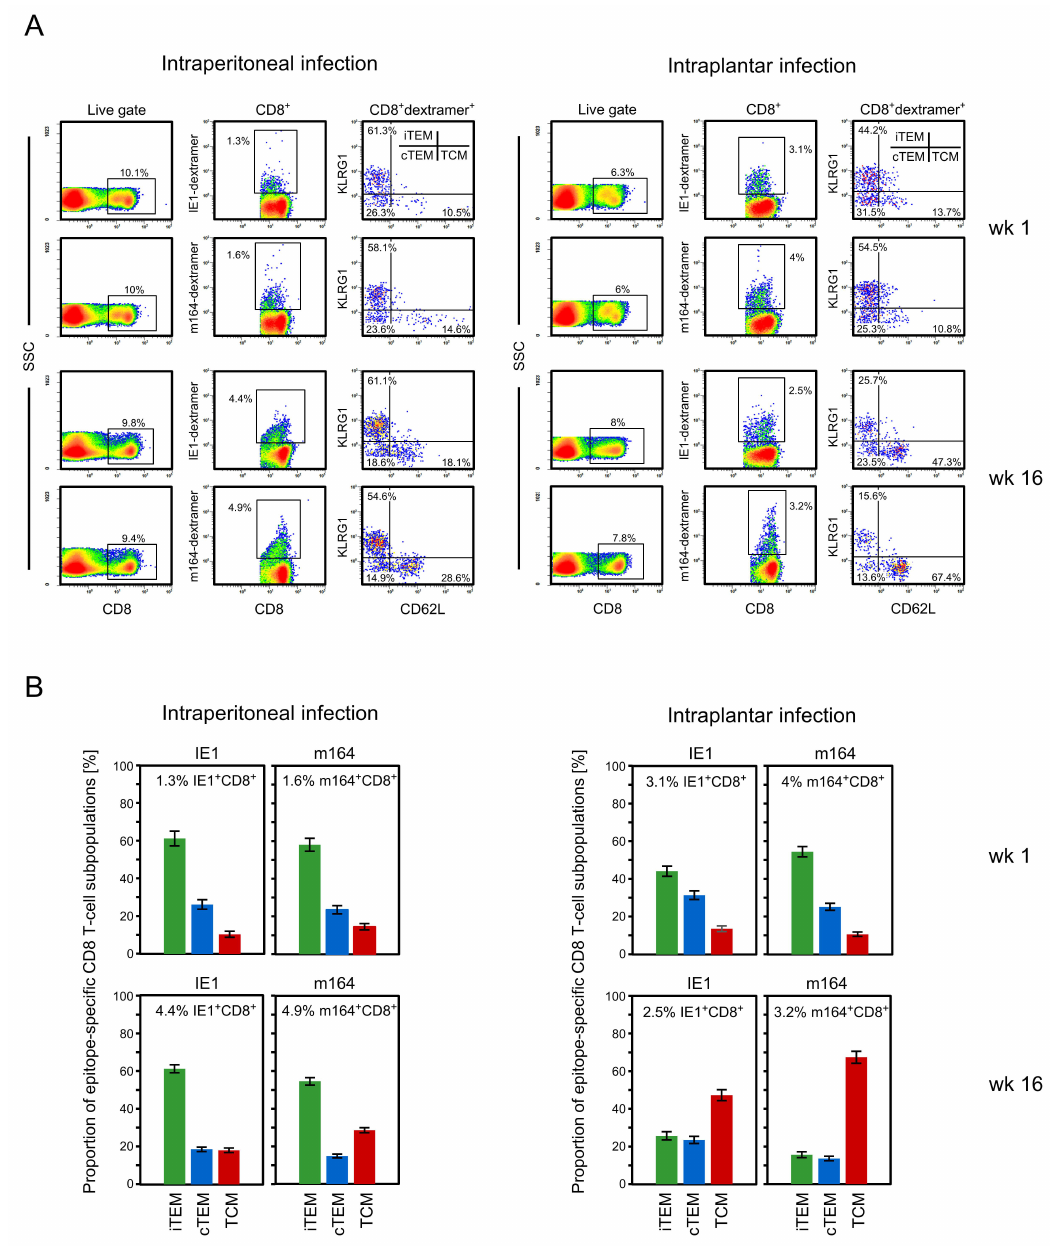
Figure 1. Comparison of intraperitoneal and intraplantar infection. Immunomagnetically-purified CD8 T cells derived from the spleens of immunocompetent BALB / c mice (pool of 4–5 mice per time of analysis) were tested at the indicated times, after intraperitoneal or intraplantar infection with 10 5 plaque-forming units (PFU) of murine cytomegalovirus (mCMV). ( A ) Cytofluorometric analysis for defining activation phenotypes of IE1 and m164 epitope-specific CD8 T cells. After setting a ‘live gate’ in the forward vs. sideward scatter (SSC) plot (not shown), a second gate was set on CD8 T cells and a third gate was set on CD8 T cells stained with the respective MHC-I-peptide dextramer. Gated cells were tested for the expression of the activation markers CD62L and KLRG1, defining the populations inflationary e ff ector-memory T cells (iTEM) (KLGR1 + CD62L − ), conventional e ff ector memory T cells (cTEM) (KLGR1 − CD62L − ), and central memory T cells (TCM) (KLGR1 − CD62L + ). ( B ) Proportions of the activation phenotypes. iTEM (green bars), cTEM (blue bars), TCM (red bars). The standard error is